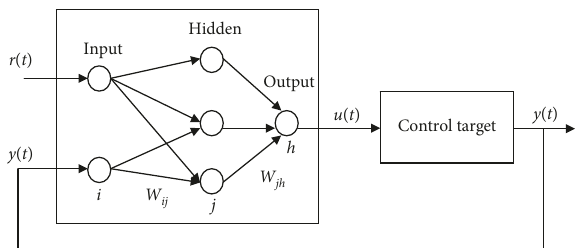
Figure 4: Schematic diagram of a BP-NN